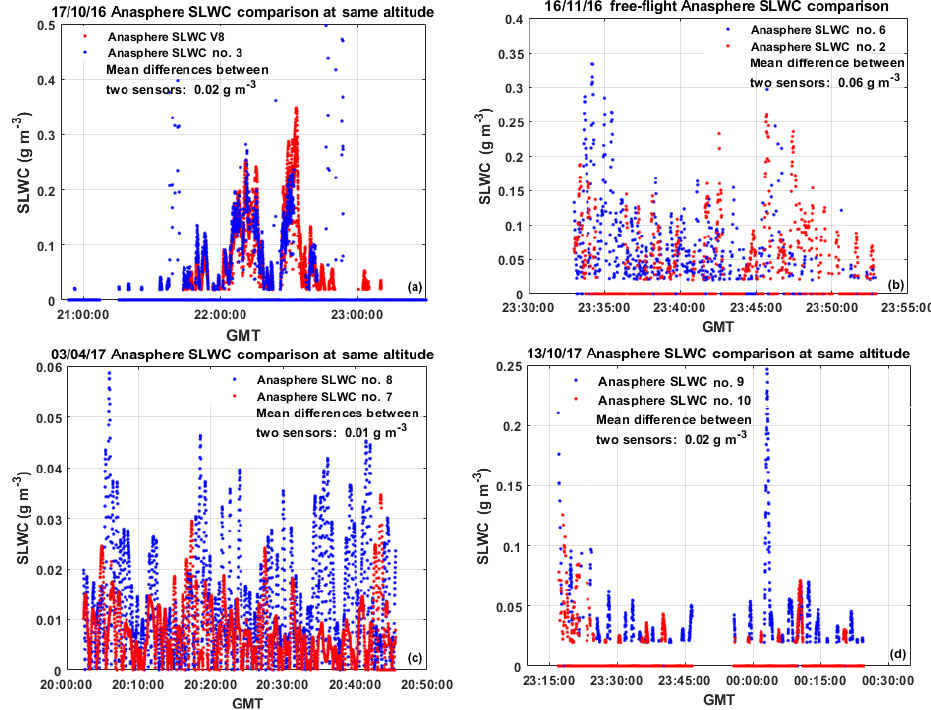
Figure 3. Results of four side-by-side comparison flights of Anasphere SLWC sondes.